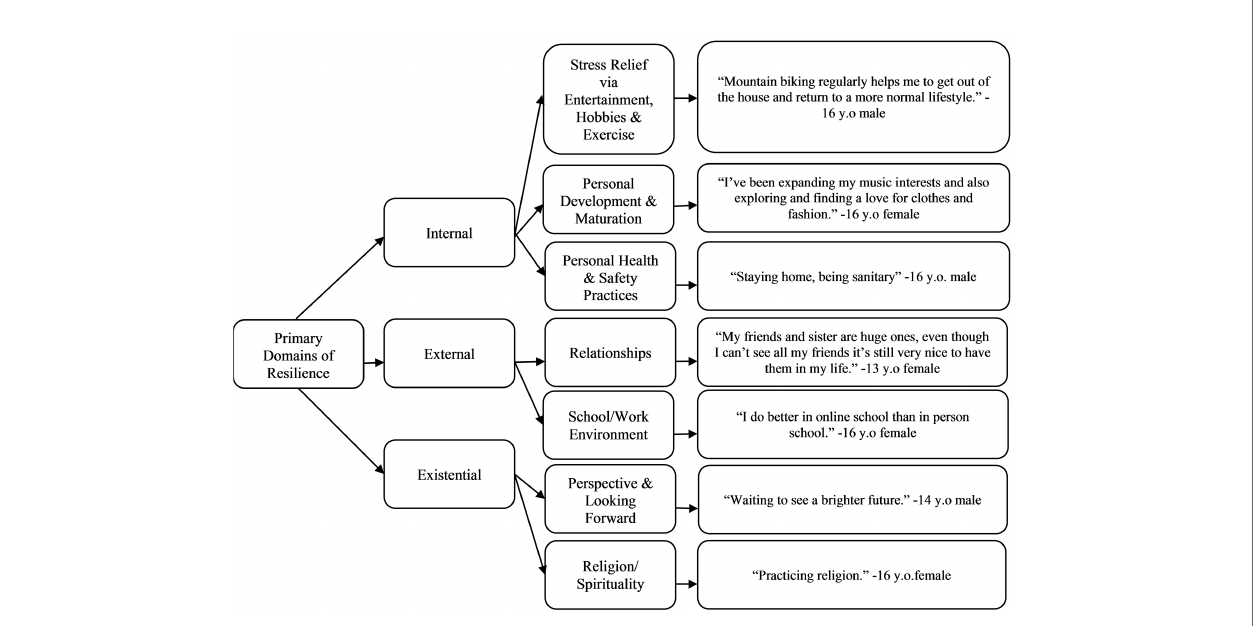
FIGURE 2 | Themes and code categories of teen-reported resilience with example